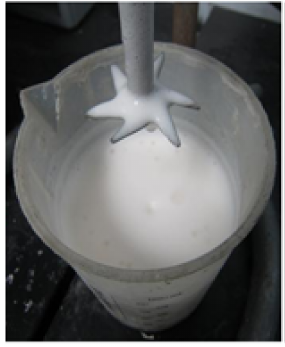
Figure 4. Foam generation in water via high-speed mixing.